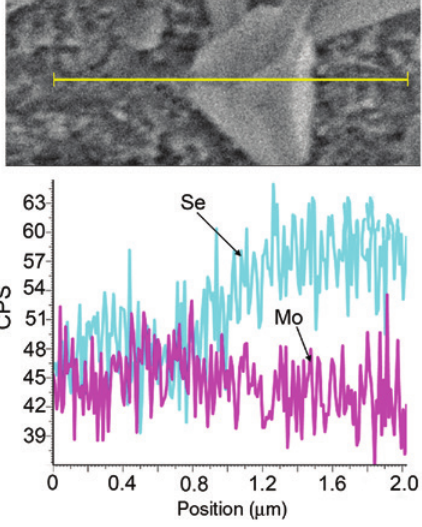
Figure 3: Elemental profiles measured on the surface of Mo film deposited at 3 mTorr after selenization by an EDX line scan.